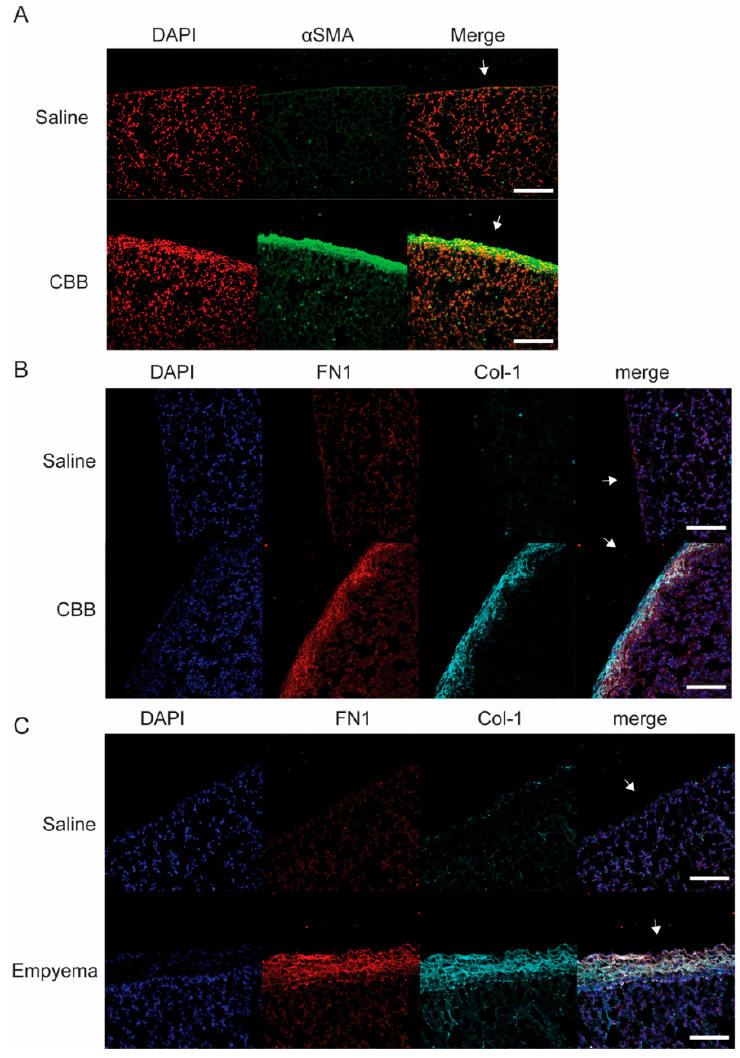
Figure 1. Increased fibronectin (FN1) deposition in two fibrosing pleural injury models in mice: Carbon black bleomycin ( CBB) and empyema. ( A ) Lung tissues sections from saline and CBB-treated mice were stained for α -smooth muscle actin ( α -SMA; green) and nuclei (red). α -SMA were localized at the pleura in CBB-treated mice. Representative image of n = 3 tissues. ( B ) Lung tissues sections from saline and CBB-treated mice were stained for FN1 (red), Collagen 1 (Col-1; cyan) and nuclei (blue). FN1 and Col-1 were colocalized at the pleura in CBB-treated mice. Representative image of n = 5 tissues. ( C ) Lung tissue sections from saline and empyema -treated mice were stained for FN1 (red), Col-1 (cyan) and nuclei (blue). FN1 and Col-1 were colocalized at the pleura in empyema lung tissues. Representative image of n = 5 tissues. White arrows indicate pleura. Scale bars; 100 μ m.